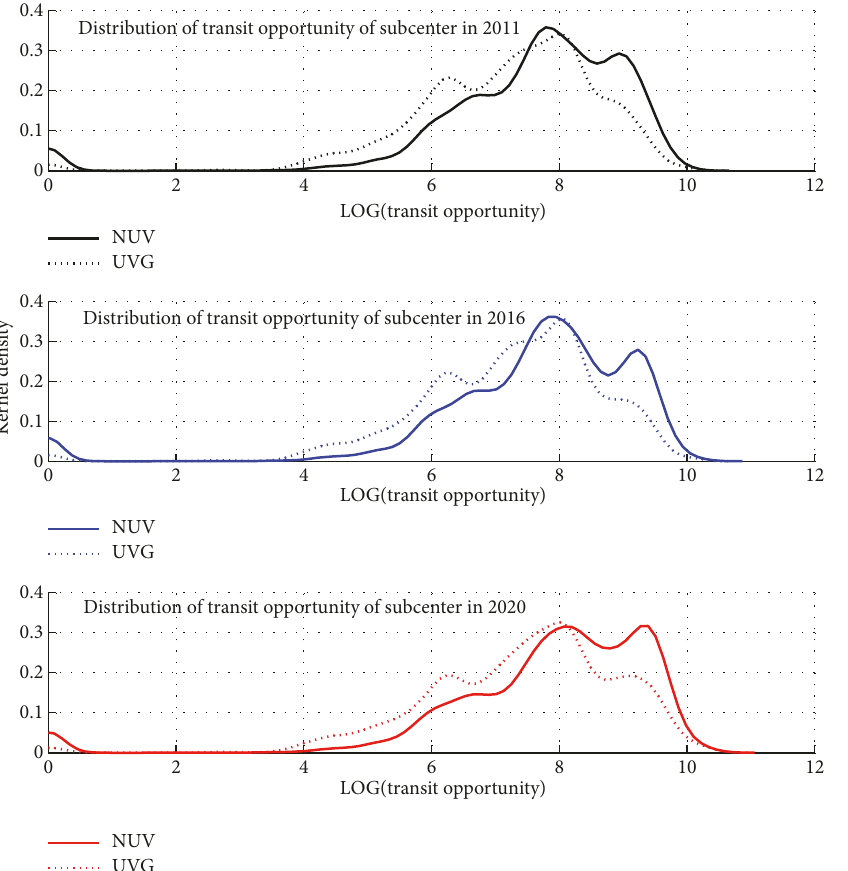
Figure 7: Comparisons of the probability distribution of the two groups in